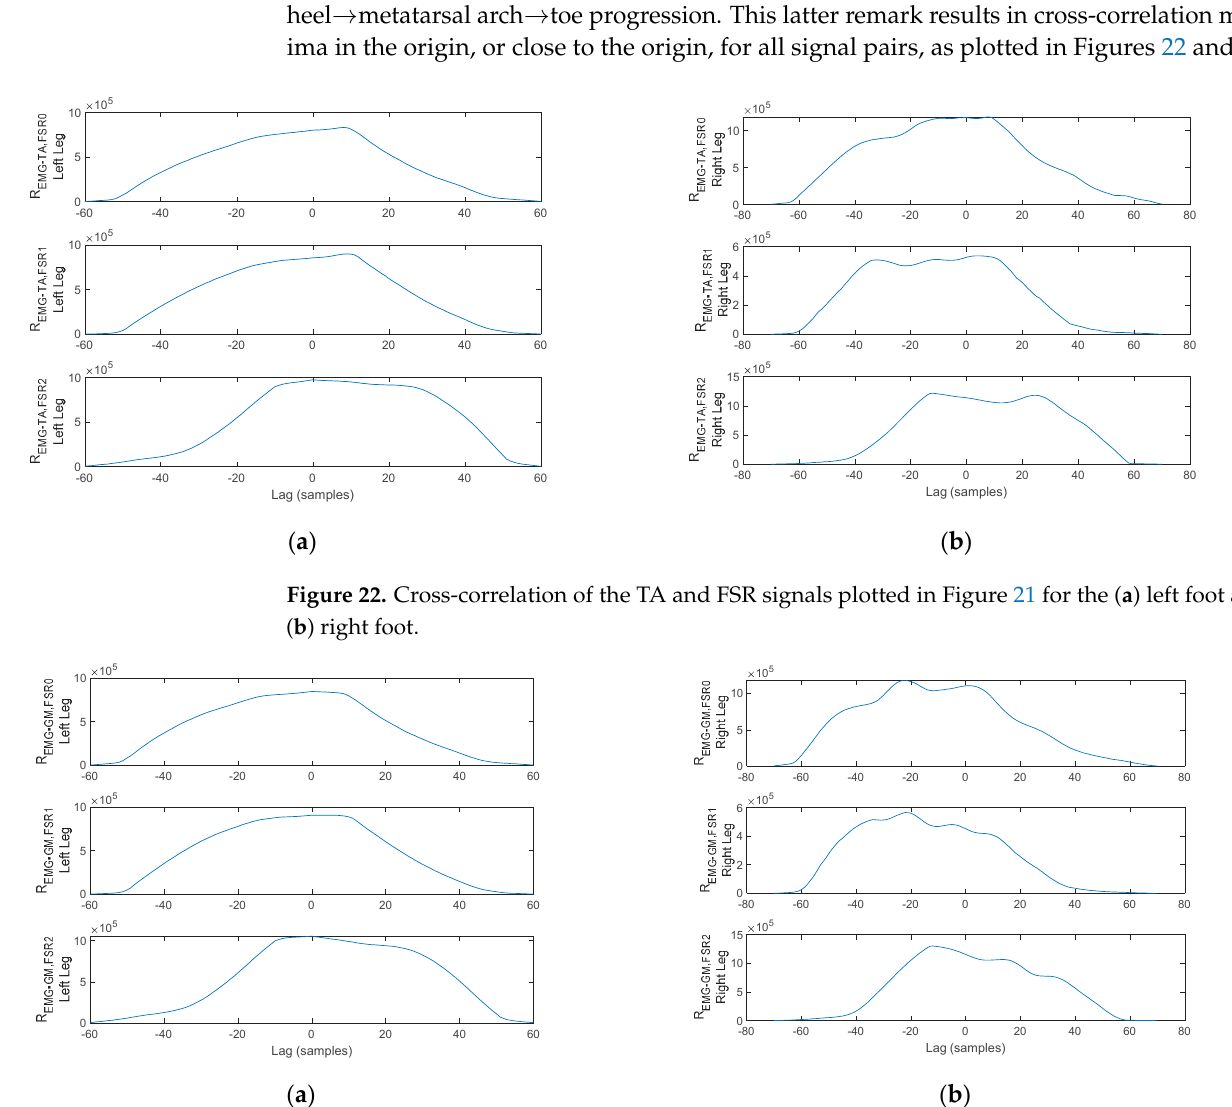
Figure 23. Cross-correlation of the GM and FSR signals plotted in Figure 21 for the ( a ) left foot and ( b ) right foot.